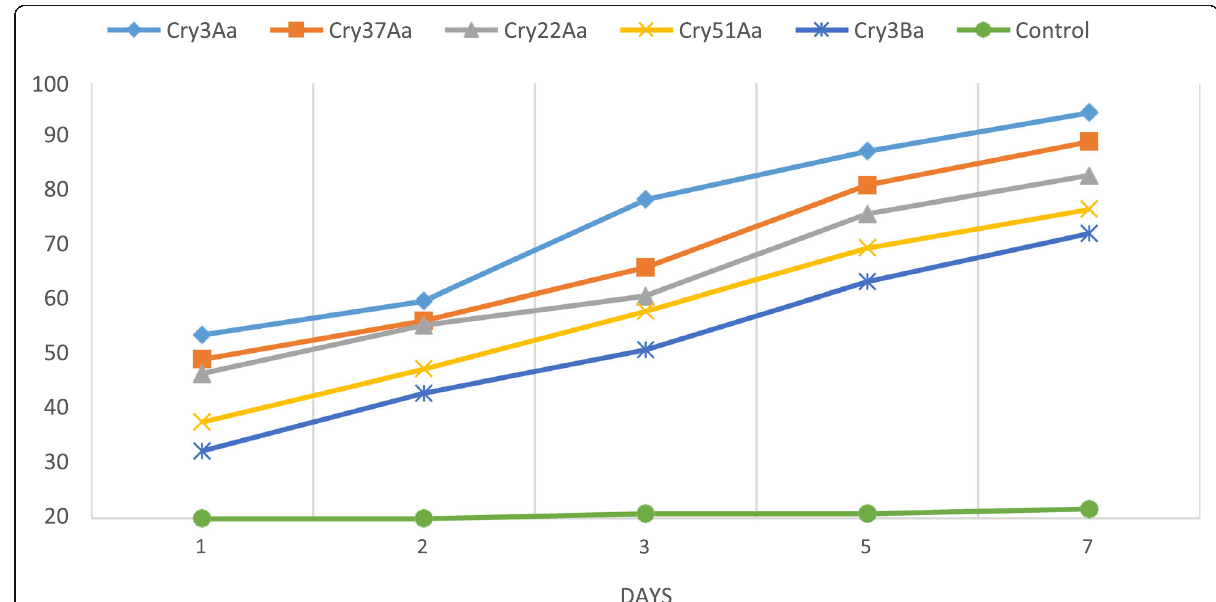
Fig. 1 Mean mortality percentages among third instar larvae of Tribolium castaneum after 7 days continuous treatment by the highest concentration (2 g/10 g) of Cry protein of various